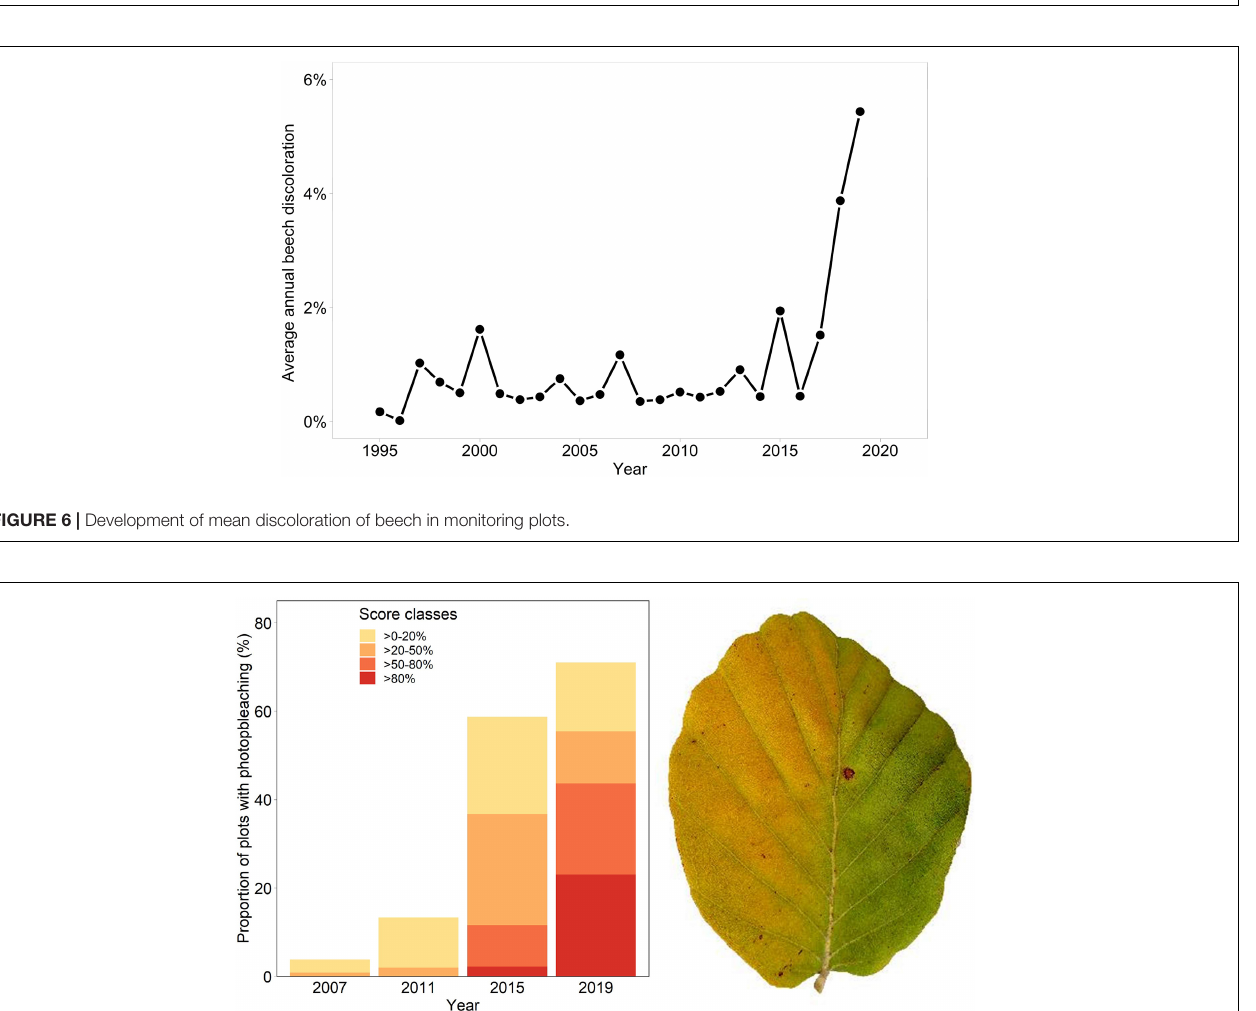
FIGURE 5 | Relation between severe beech crown transparency and (A) the concentration of phosphorus (A) as well as the concentration of potassium (B) . The dashed lines indicate the lower threshold values for normal nutrition according to Göttlein (2016).